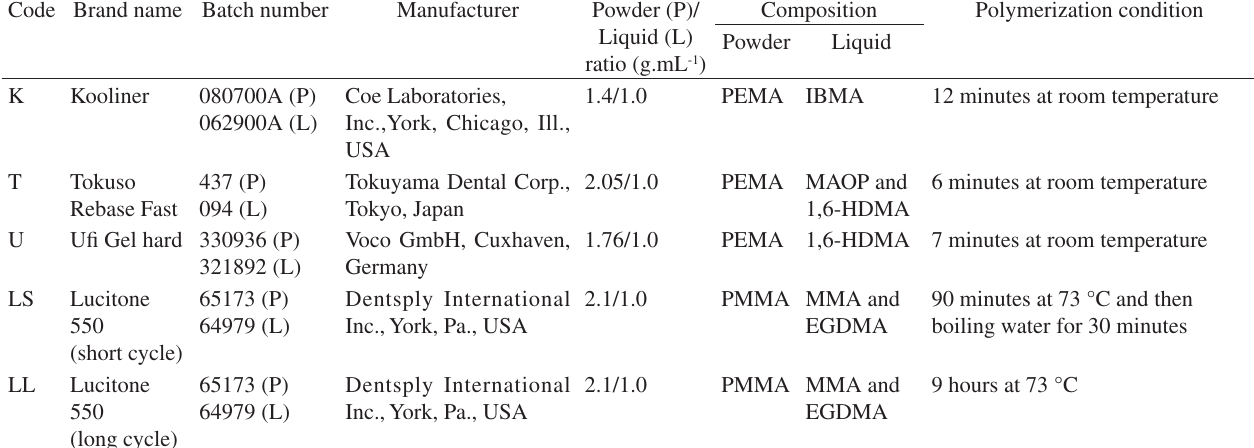
Table 1. Materials evaluated in this